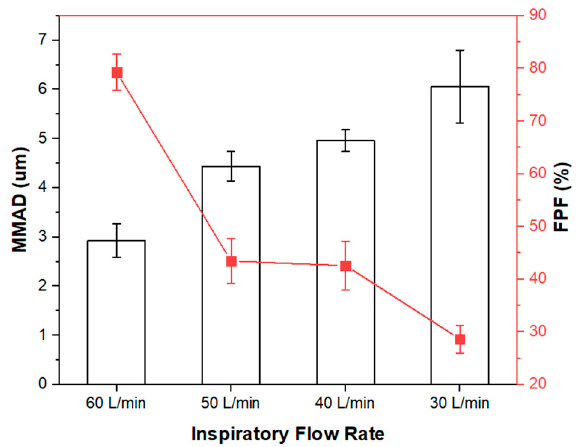
Figure 7. In vitro aerosolization performance of the spray-dried F1 at different inspiratory flow